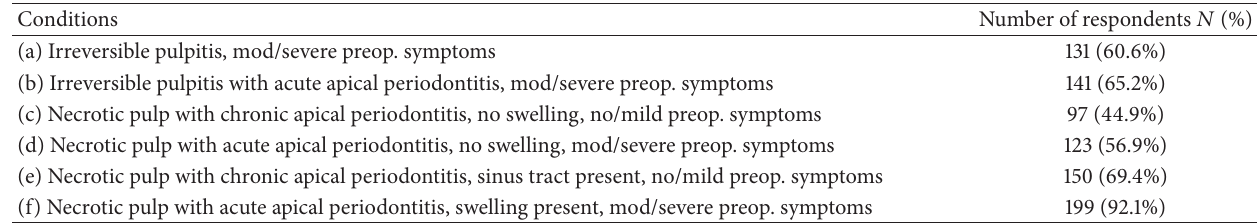
Table 4: Endodontic conditions necessitating antibiotics